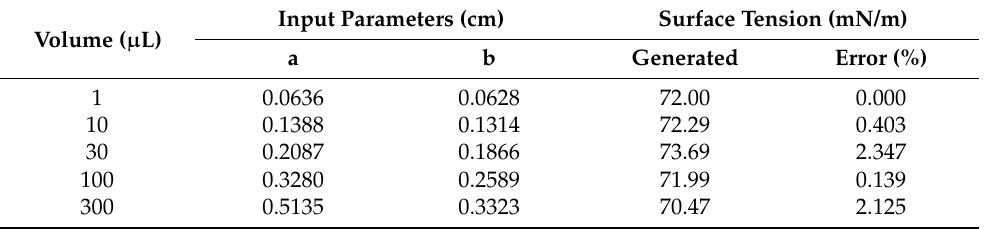
Table 1. Comparison between nominal and generated surface tension of droplets at different